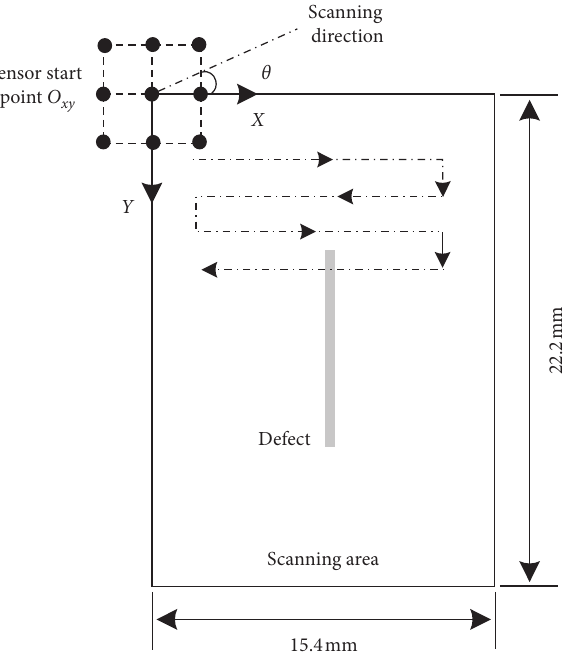
Figure 7: Schematic diagram of